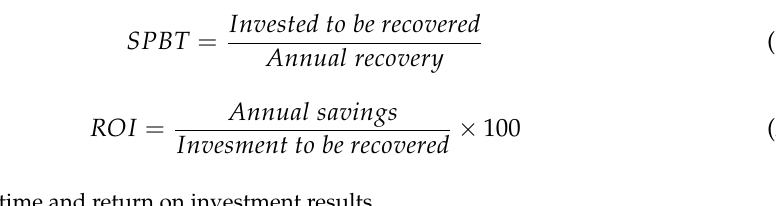
Table 13. Payback time and return on investment